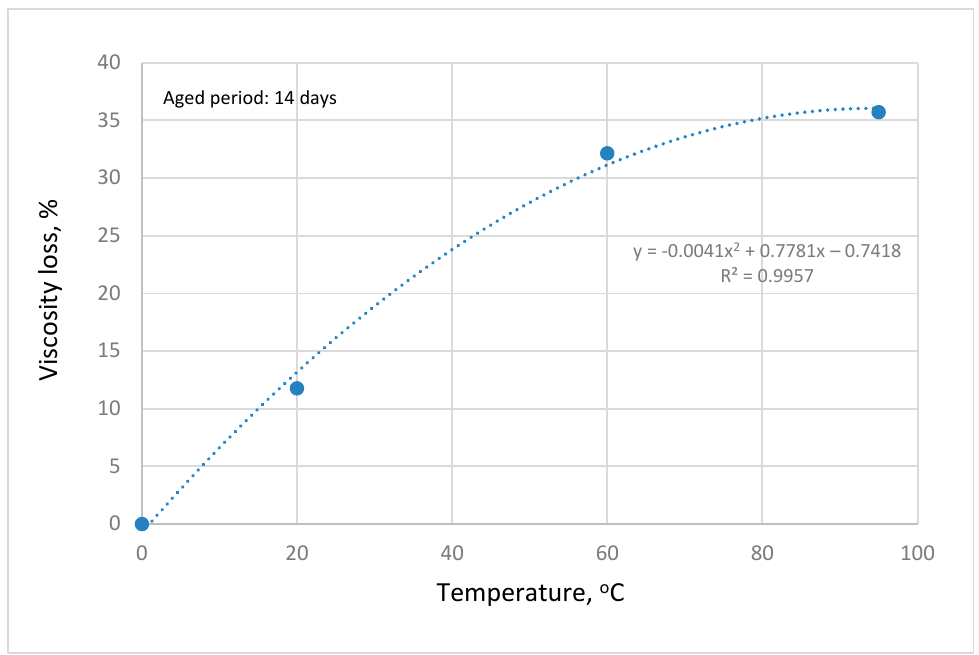
Figure 8. Viscosity loss of OM in seawater during the aging period of 14 days with different tem- peratures.